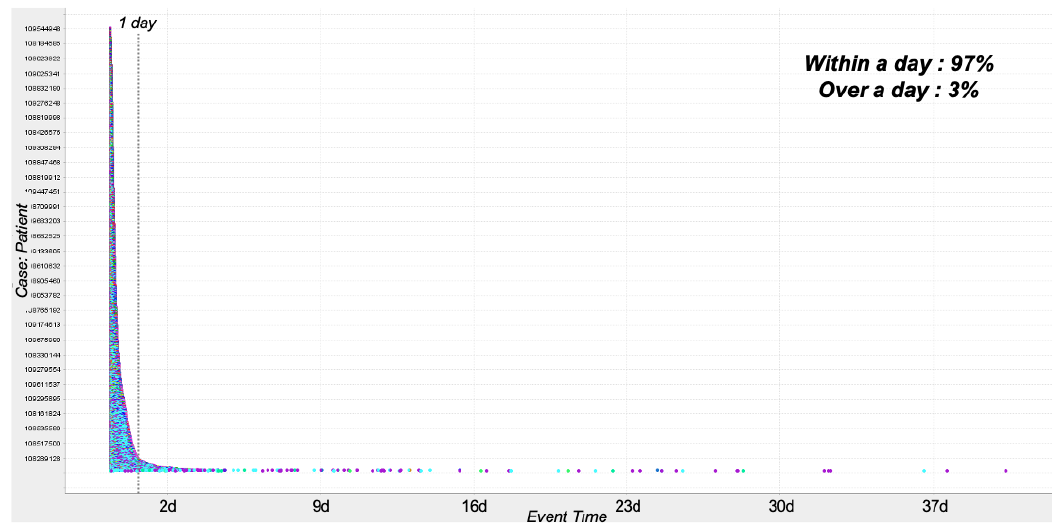
Figure 2. The length of stay analysis result using the dotted